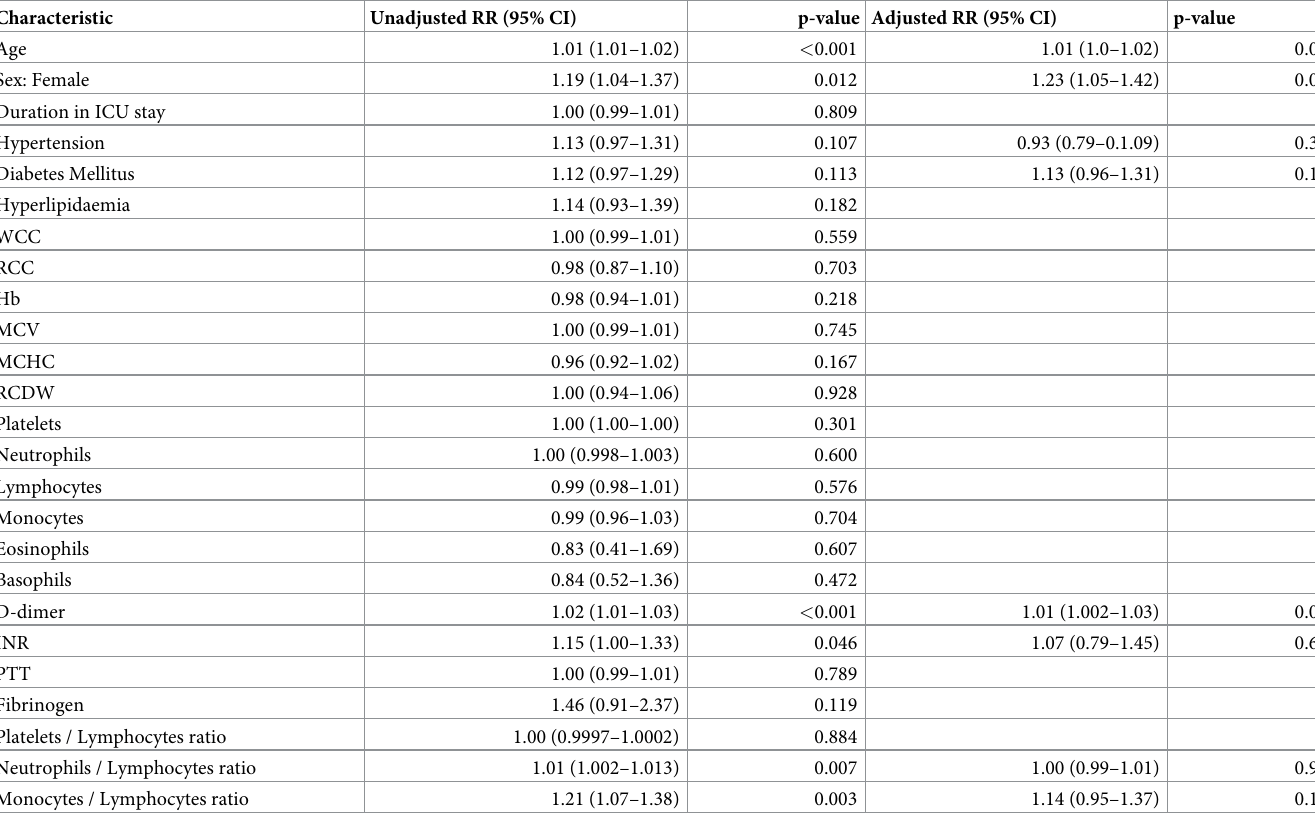
Table 3. Association of socio-demographic and haematology parameters with mortality status in COVID-19 ICU patients. Characteristic